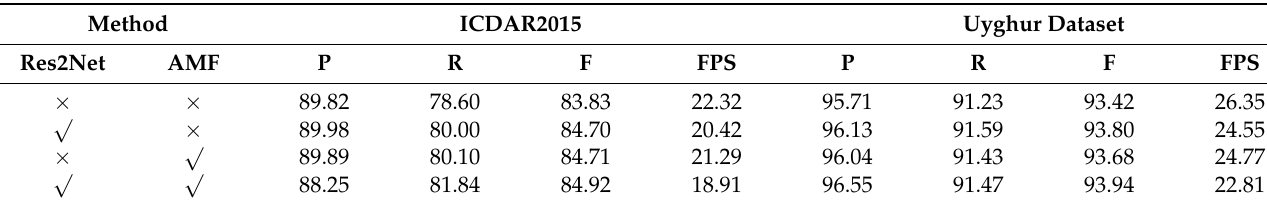
Table 2. Ablation experiments of different